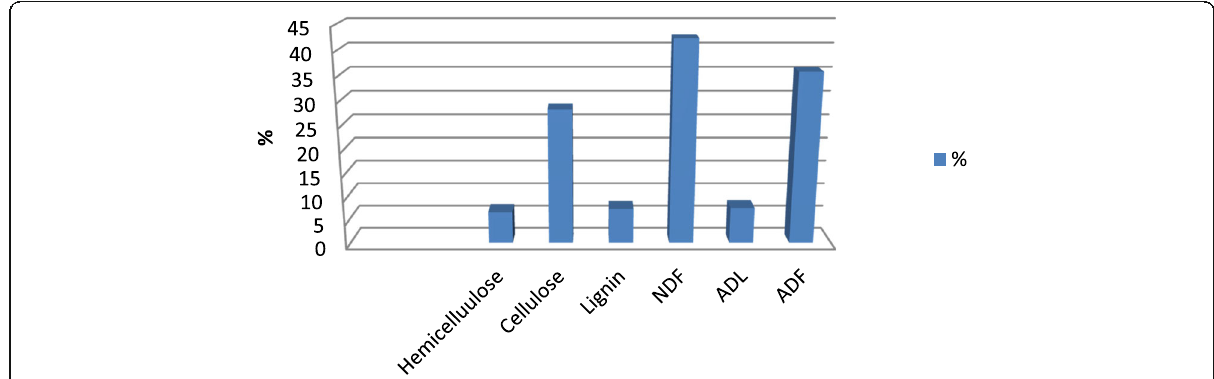
Fig. 2 Dietary fiber composition of jatropha hull. ADF acid detergent fiber, ADL acid detergent lignin, NDF neutral detergent